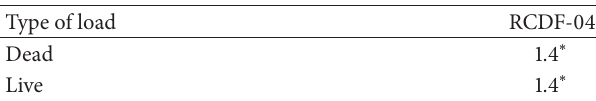
Table 1: Load factors, 𝛾 .